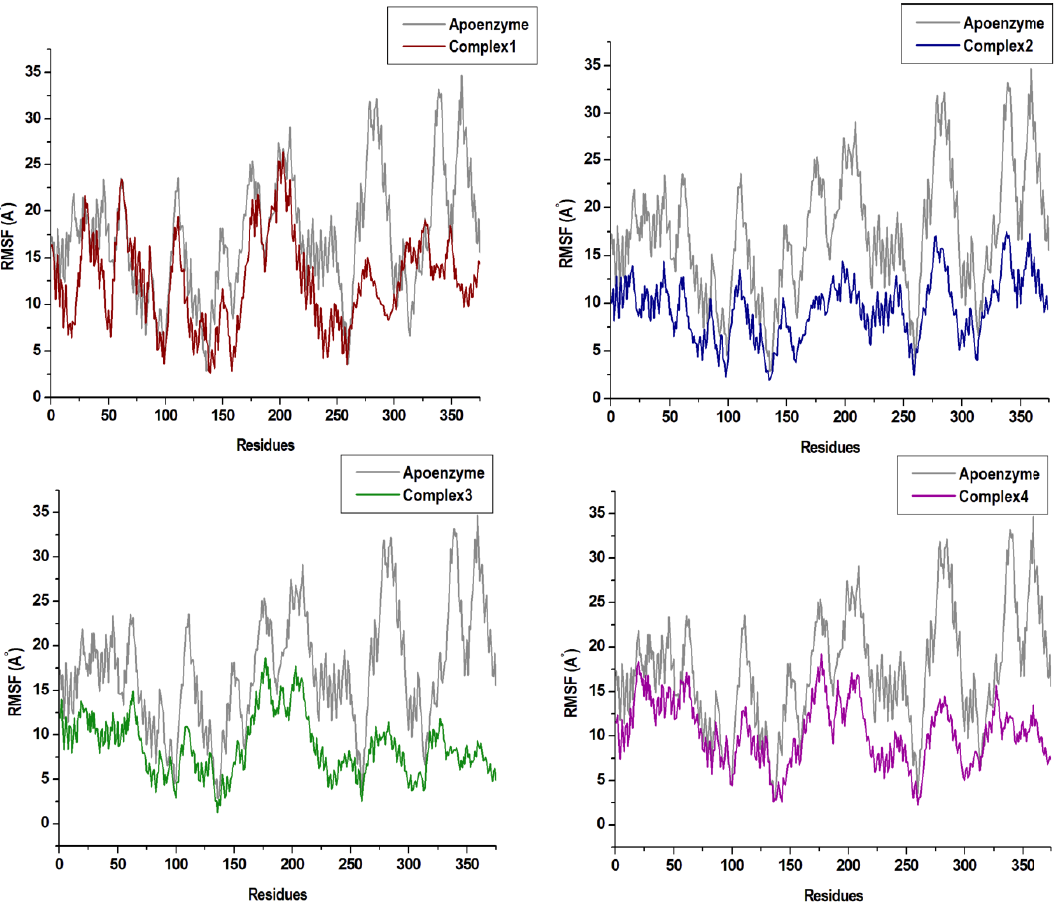
Figure 5. The RMSF plots of the four compounds in complex with Nedd4-1 in comparison with the Apo enzyme.